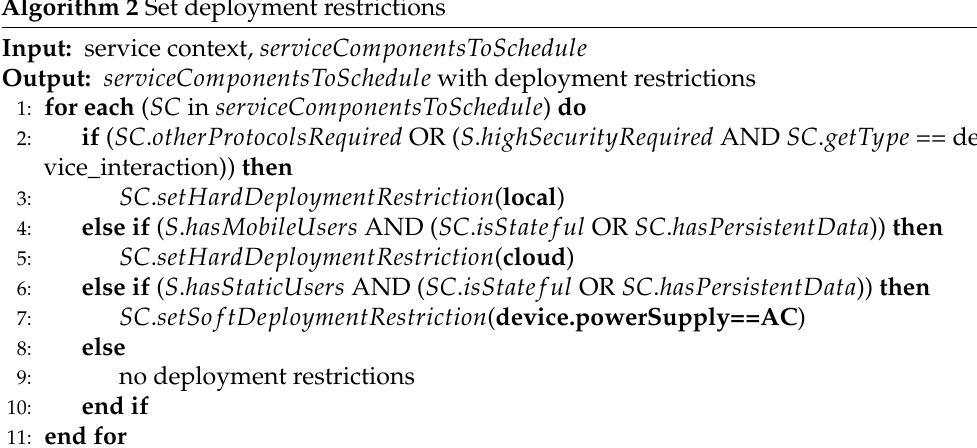
Algorithm 2 Set deployment restrictions